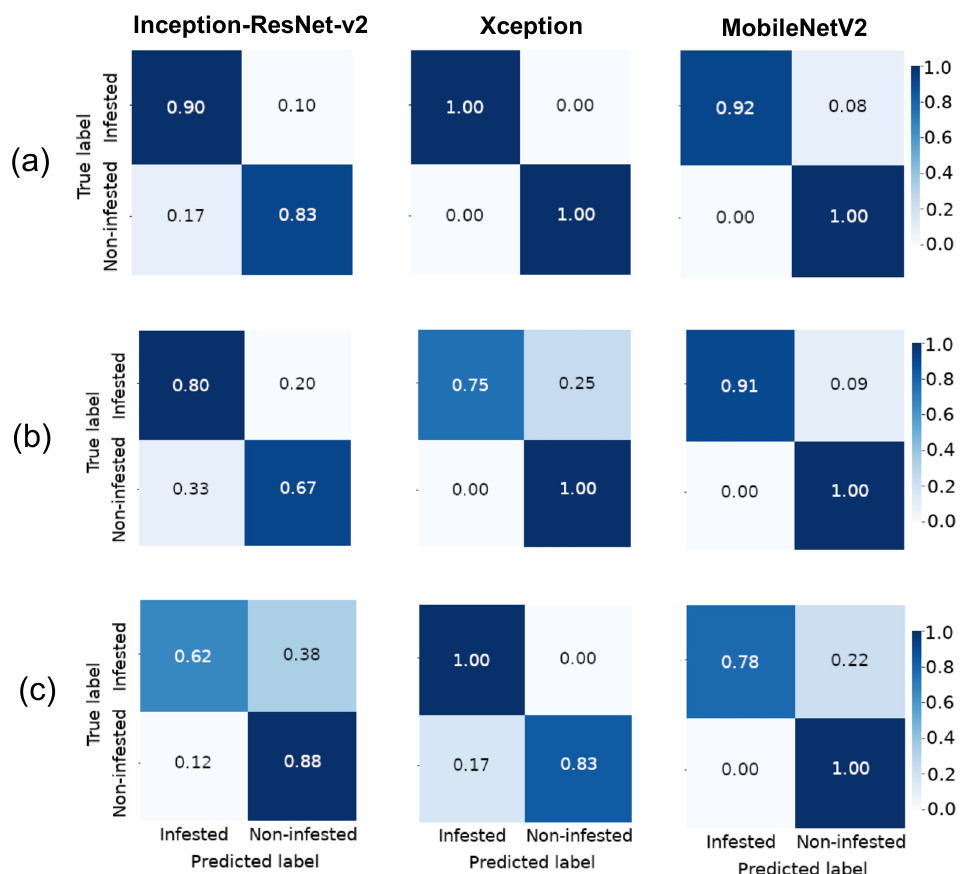
Figure 6. Confusion matrices for classification of X-ray images from non-infested maize grains and grains infested with Sitophilus zeamais based on Inception-ResNet-v2, Xception and MobileNetV2 classifier architectures on training ( a ), validation ( b ) and test ( c ) datasets.